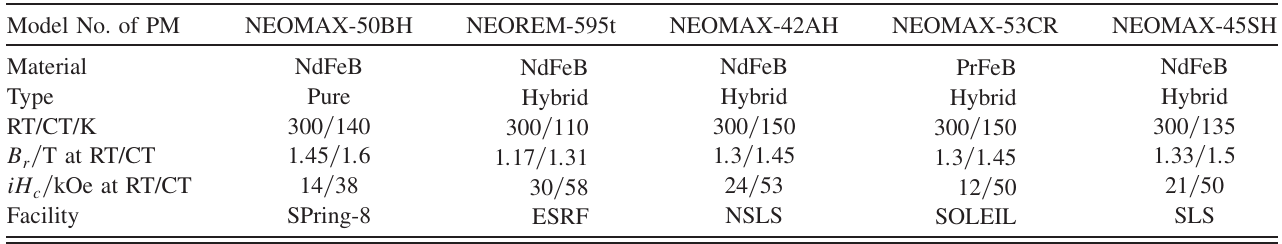
TABLE III. Parameters of permanent magnets between room temperature (RT) and cryogenic temperature (CT) (NEOMAX are products of Hitachi